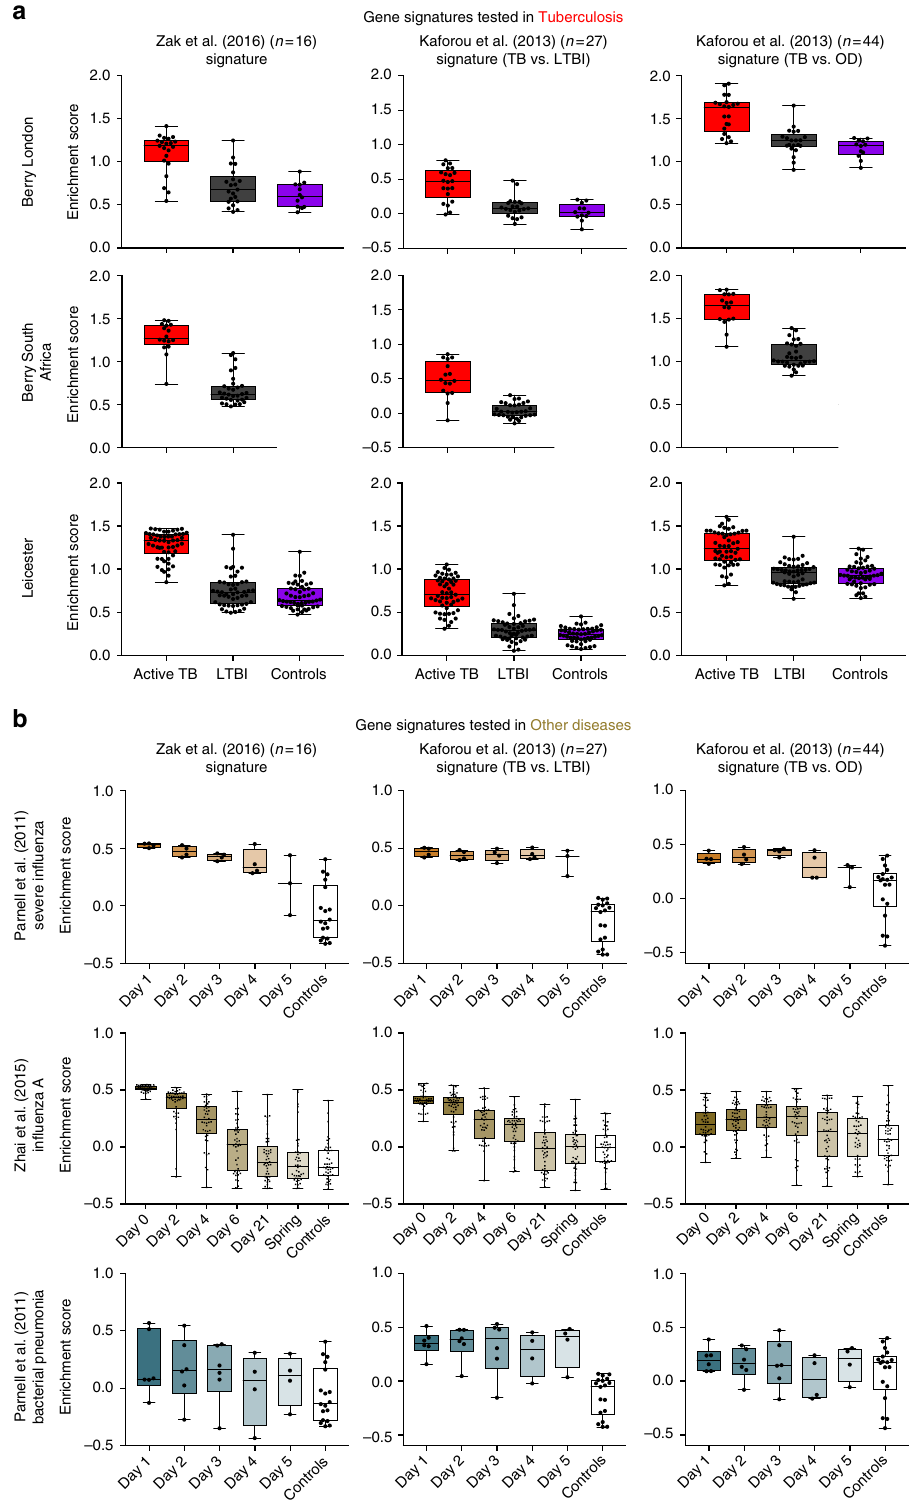
Fig. 3 Enrichment of the published reduced TB gene signatures in TB, and other viral and bacterial infections. a Box plots depicting enrichment scores derived on a single-sample basis using ssGSEA, using the 16-gene signature from Zak et al. 32 , and the 27-gene (TB vs. LTBI) and 44-gene (TB vs. other diseases (OD)) signatures from Kaforou et al. 24 in tuberculosis datasets (Berry London, Berry South Africa and Leicester), and b in datasets of other infections — severe in fl uenza from Parnell et al. 35 , In fl uenza A from Zhai et al. 36 and bacterial pneumonia from Parnell et al. 35 . The box represents the 25th to 75th percentile, with a line inside the box indicating the median and the whiskers representing the minimum to the maximum points in the data